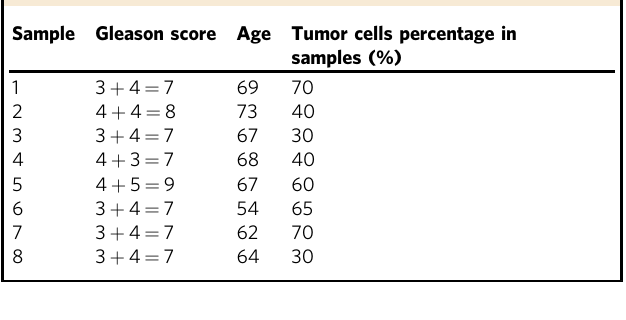
Table 1 Clinical characteristics for Netherlands cohort patient data.